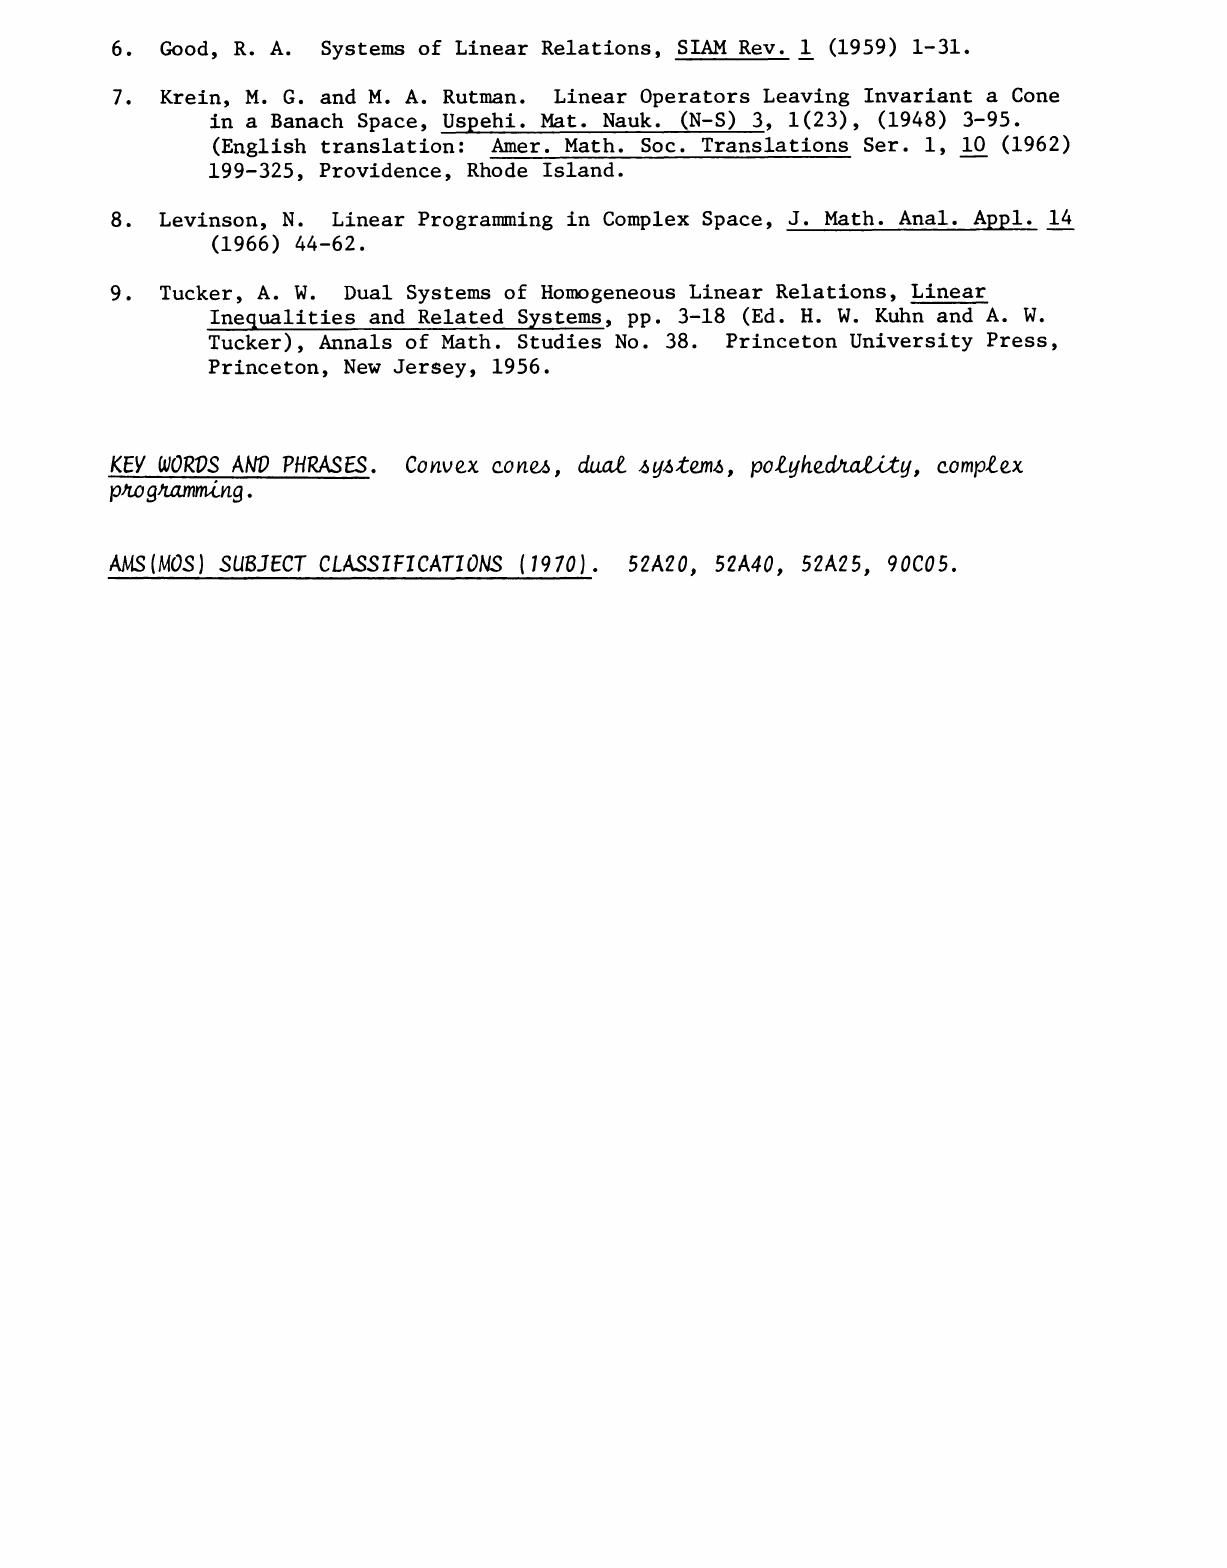
Convex con, dual systems, polyhedrality, complex